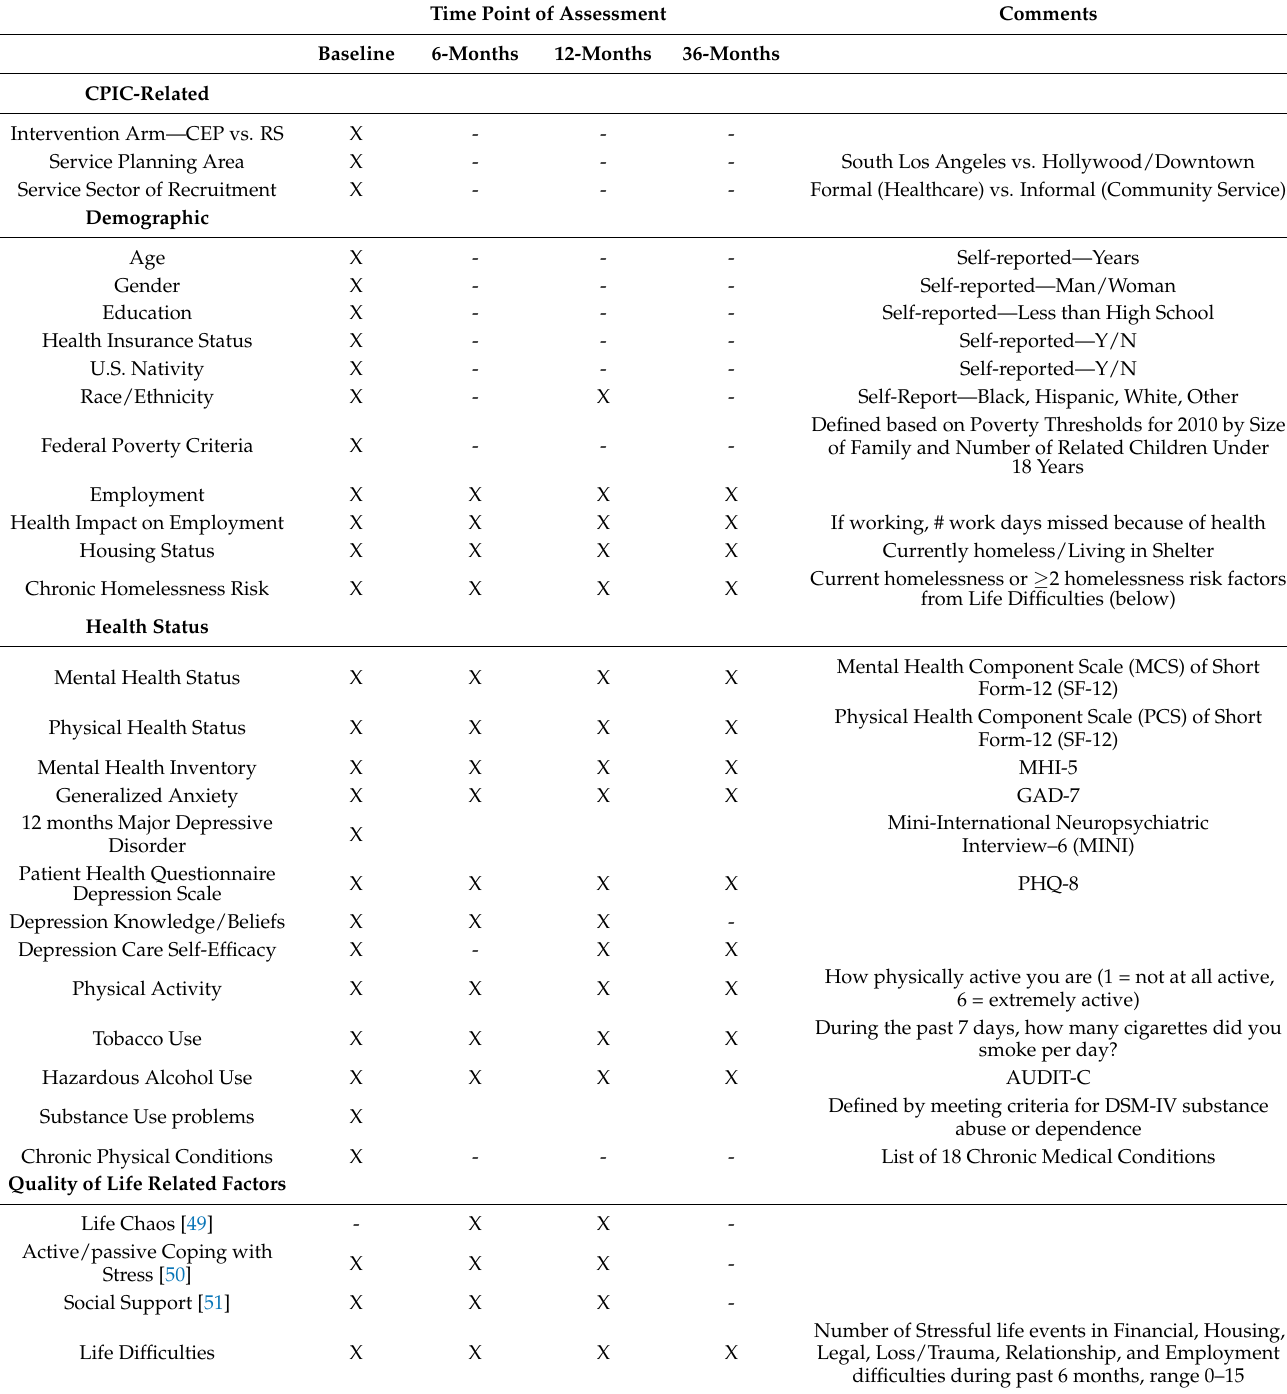
Table A1. Community Partners in Care—Independent Variables by Domain and Time Point ( N =